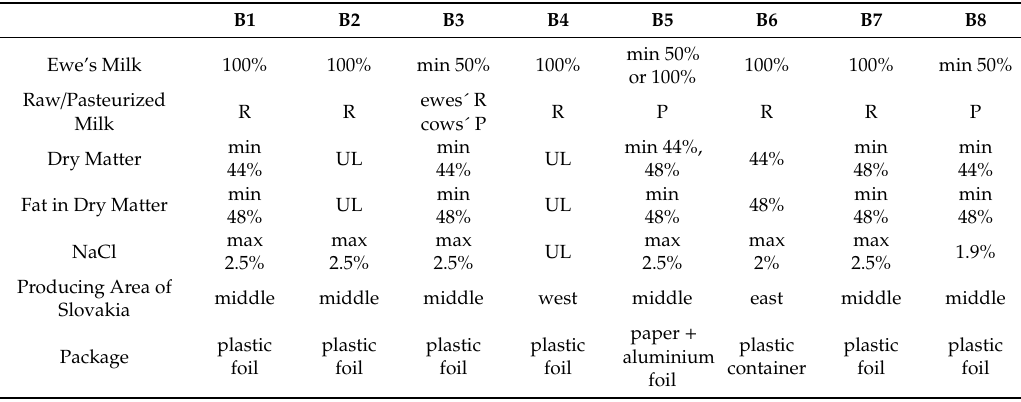
Table 1. Characterization of analyzed bryndza cheese